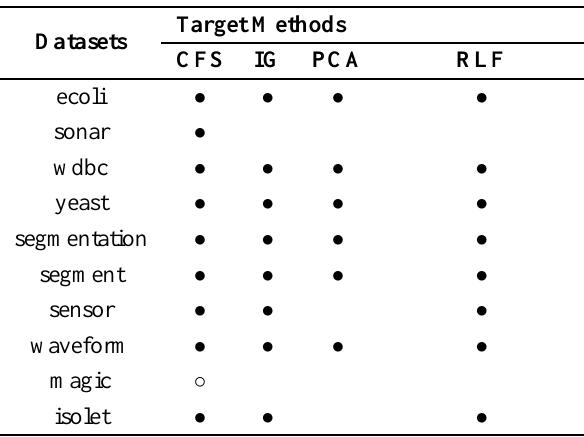
Table 3. Comparisons of our method with classical feature reduction methods by squared errors of SimpleKMeans clusterer.